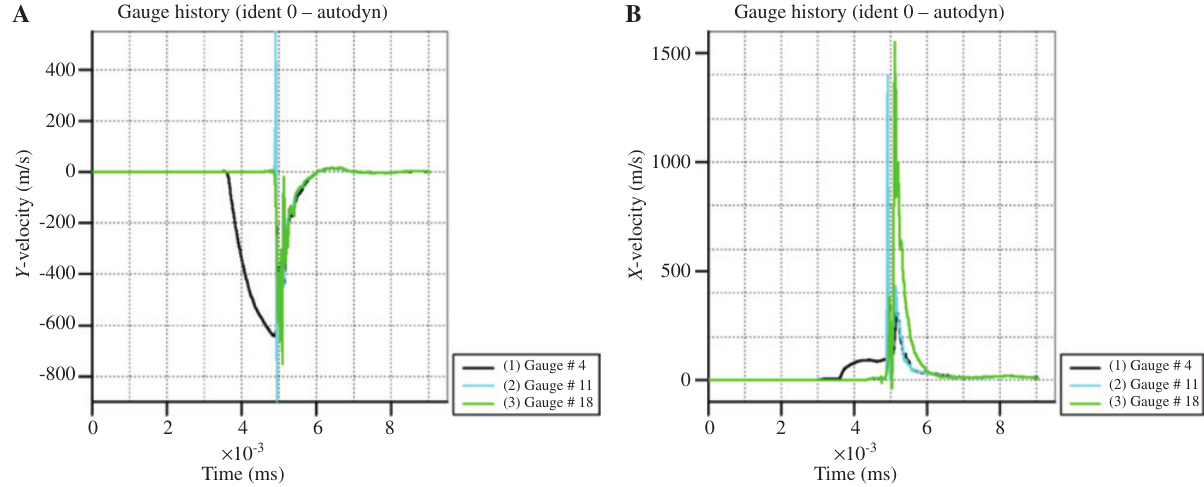
Figure 9: Velocity-time curve along the direction of propagation of detonation: (A) Y -direction velocity curve of the points 4, 11, and 18; (B) X -direction velocity curve of the points 4, 11, and 18.